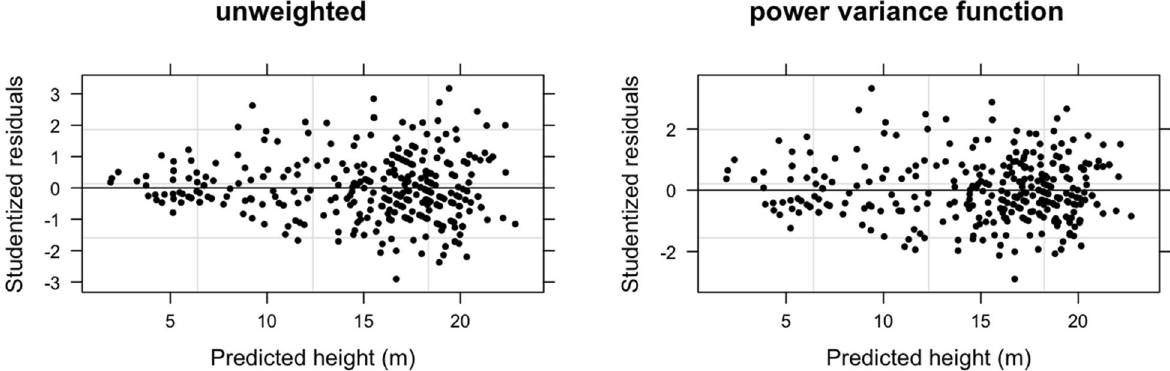
Fig. 17 The plot of studentized residuals against the predicted height for N. pumilio . The studentized residuals were obtained by fitting the generalized NLME H–D model for NP without weighting (left) and with power variance function